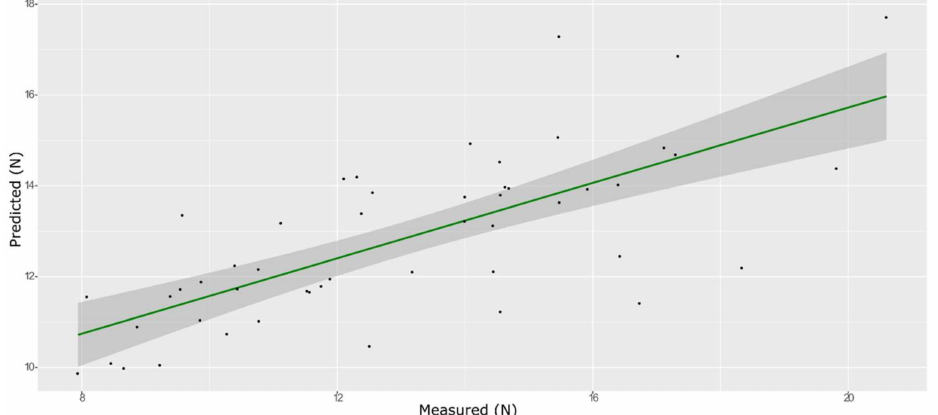
Figure 12. ANN model for BH on the test set, using the selected